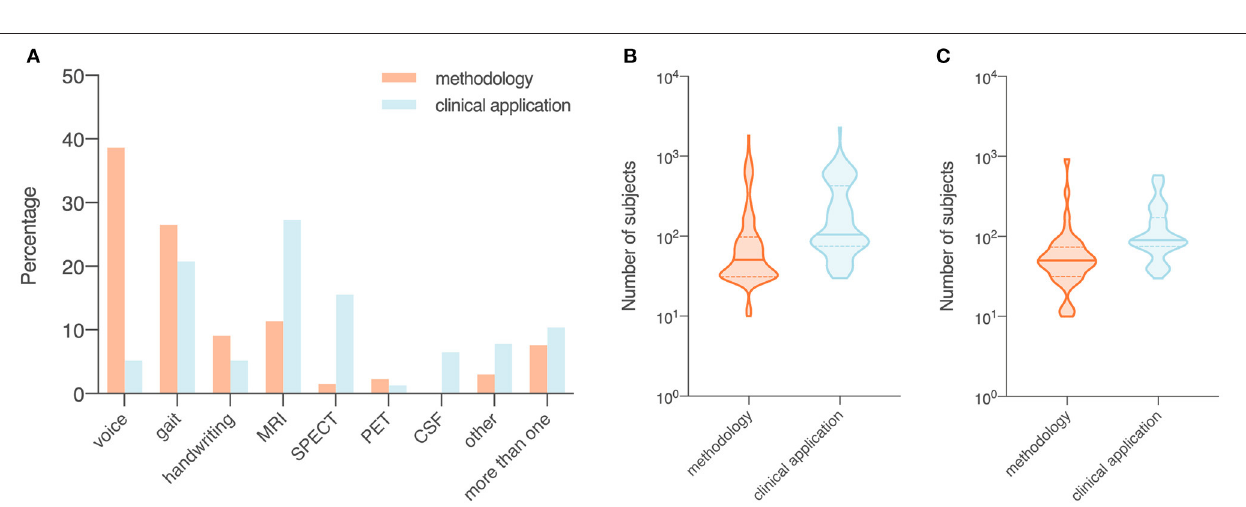
FIGURE 3 | Data modality (A) and number of subjects (B,C) of included studies, summarized by objectives (i.e., methodology or clinical application ). Orange, studies with a focus on the development of a novel technical approach to be used in the diagnosis of Parkinson’s disease (i.e., methodology ); blue, studies that investigate the use of published machine learning models or novel data modalities (i.e., clinical application ). (A) Proportion of data modalities in included studies displayed as percentages. (B) Sample size in all included studies. (C) Sample size in studies that collected data from recruited human participants. Data shown are means